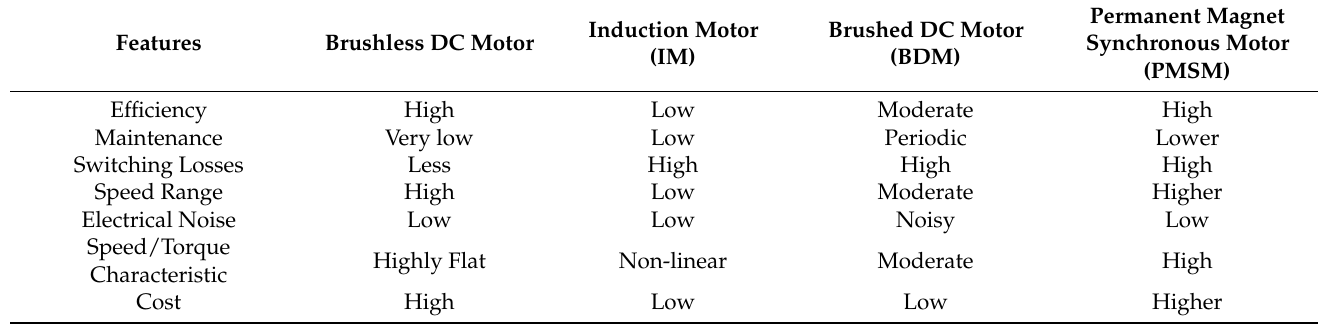
Table 1. Comparison of Motors for EV Application